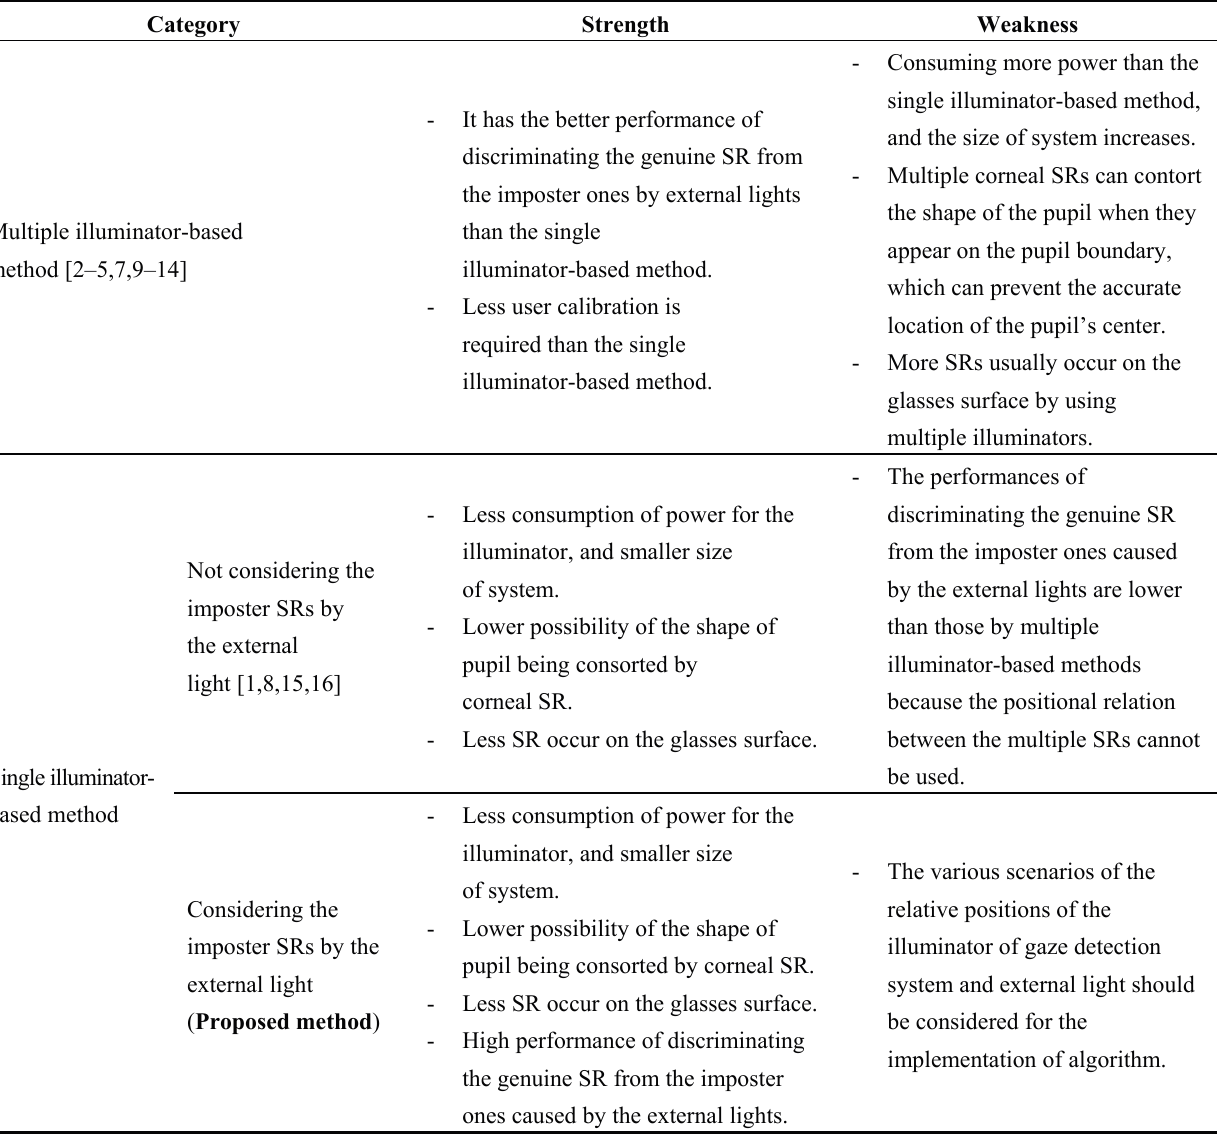
Table 1. Comparison of previous works and proposed